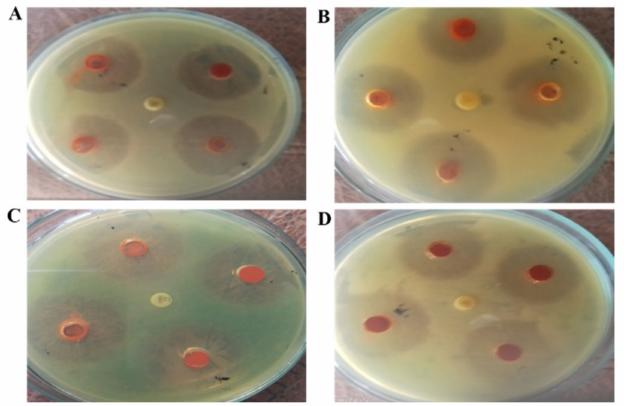
Figure 5. Assay picture of NPs against various strains ( A ) Helicobacter felis, ( B ) Helicobacter suis, ( C ) Helicobacter salomonis and ( D ) Helicobacter bizzozeronii